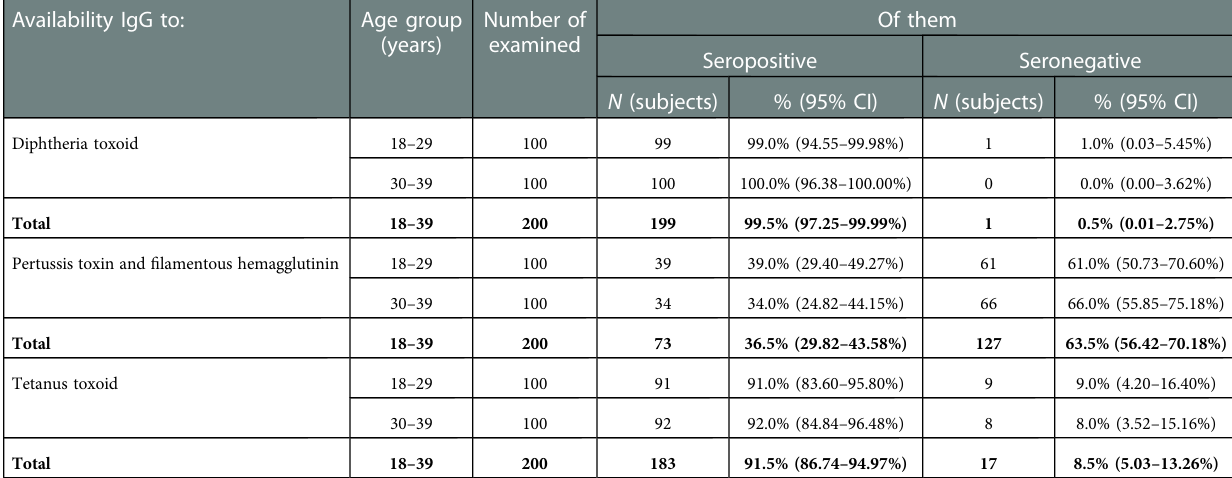
TABLE 1 IgG blood serum levels to diphtheria, tetanus, and pertussis in pregnant women. Availability IgG